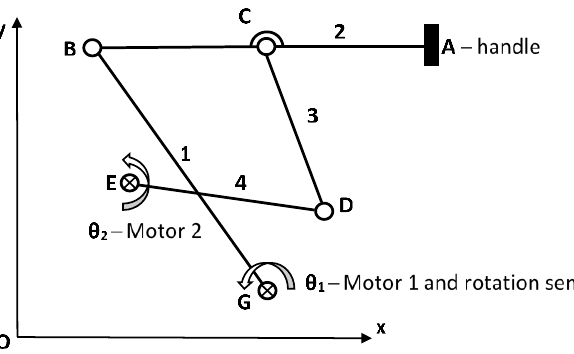
Figure 9. The design of the planar multi-bar mechanism used as haptic equipment.